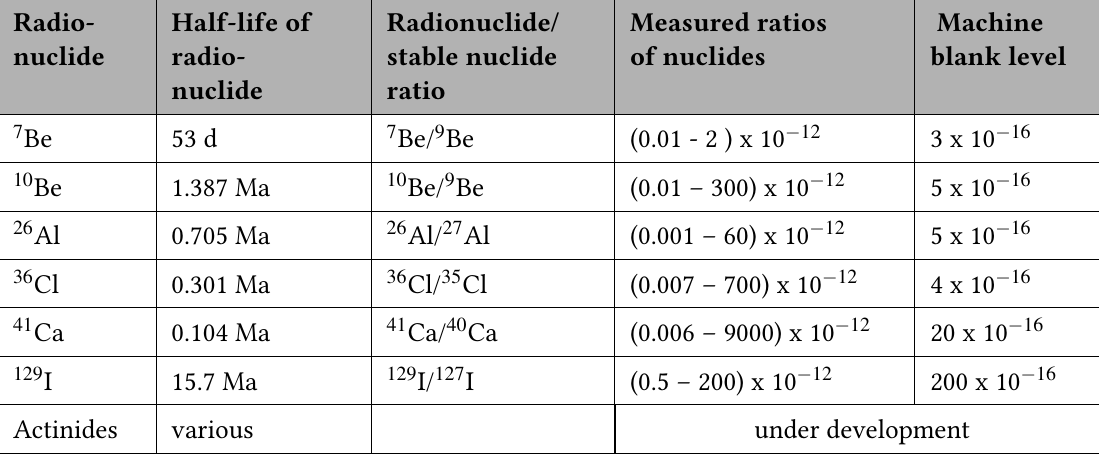
Table 3: Radionuclides measured at the DREAMS